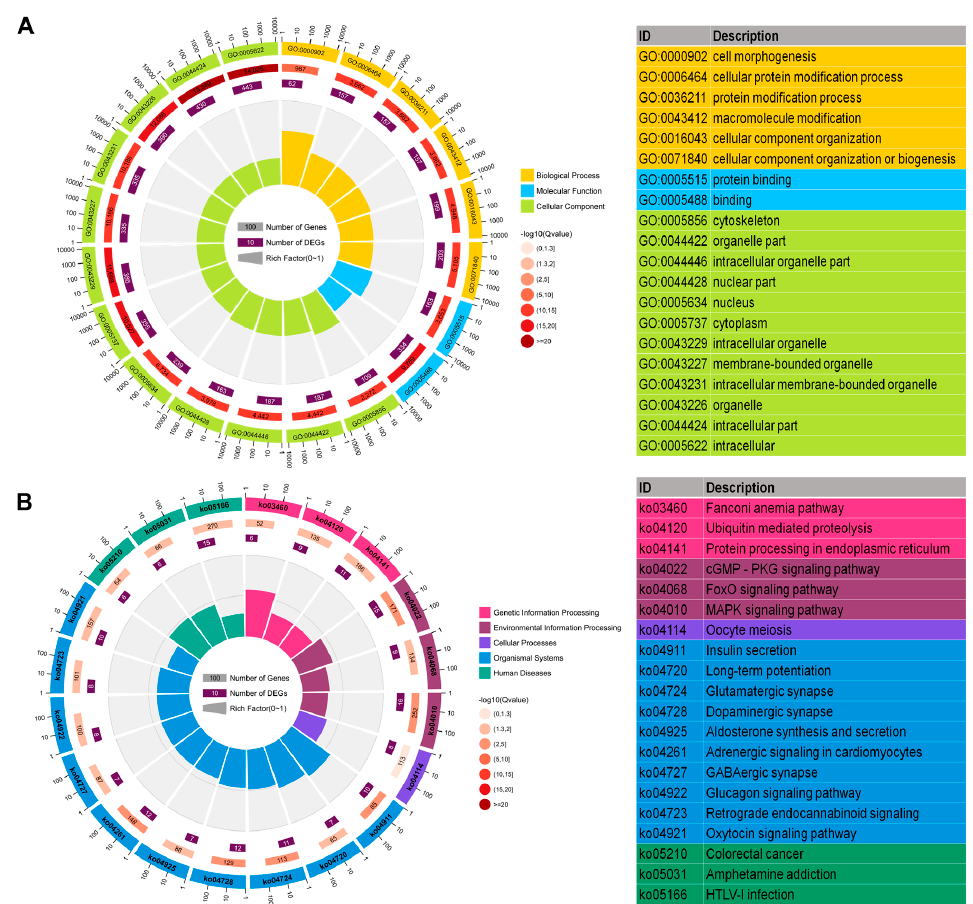
Figure 5. GO and KEGG enrichment analysis. The circular graph shows the top 20 enriched GO terms ( A ) and KEGG pathways ( B ) of source genes of 636 differentially expressed circRNAs.